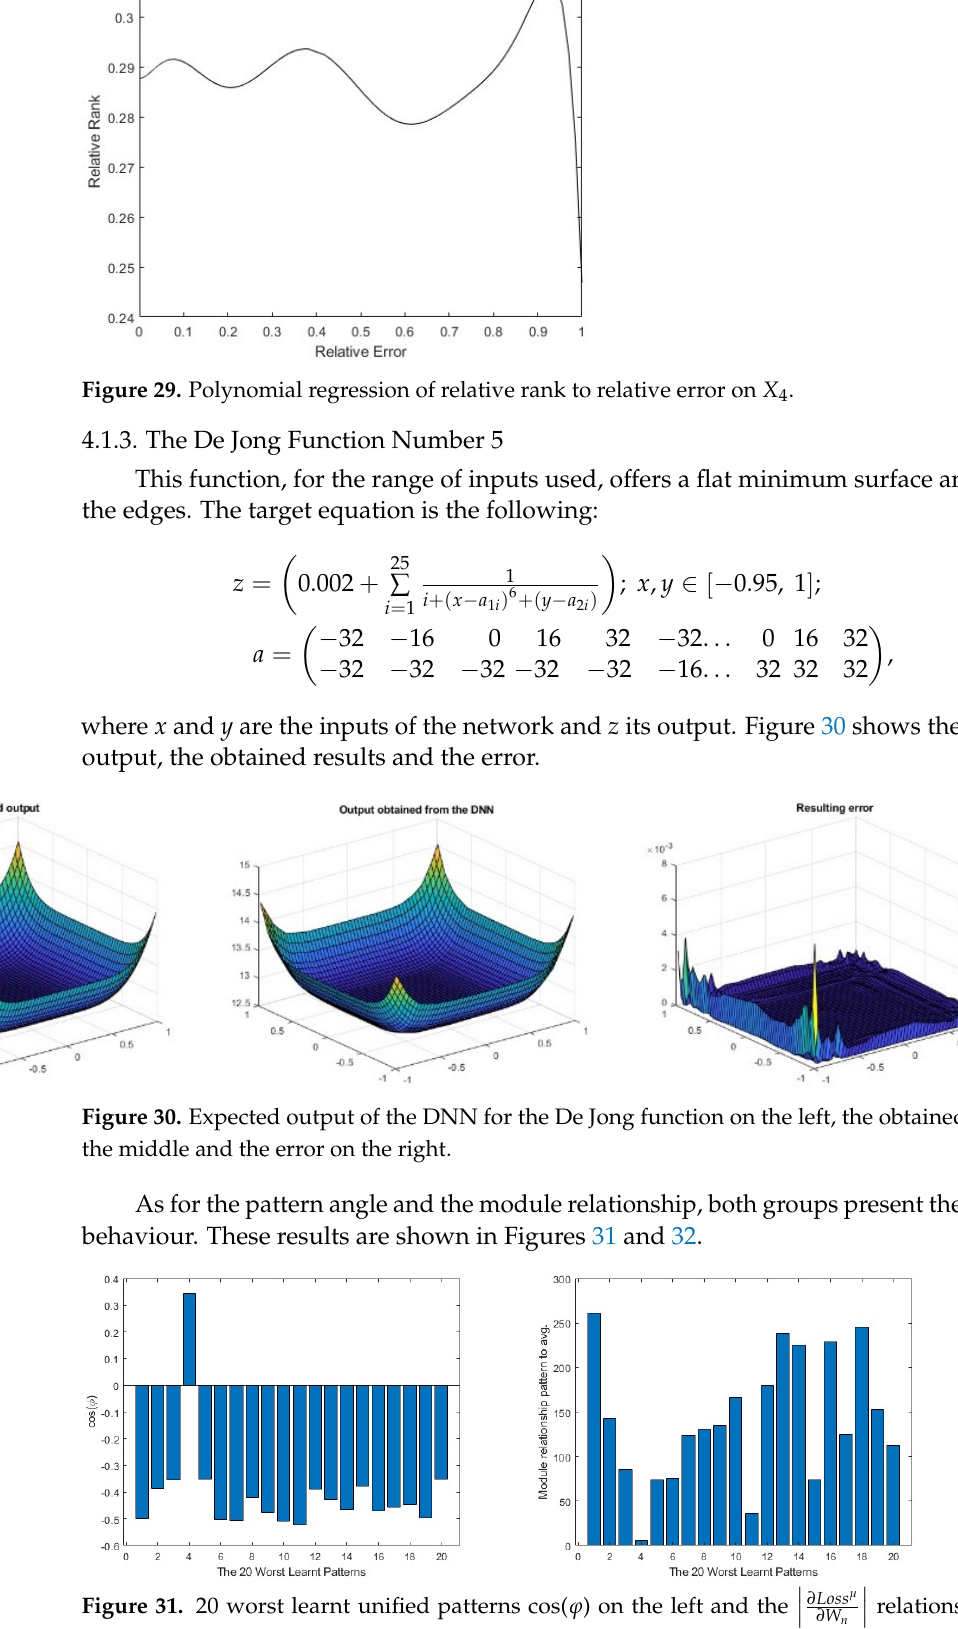
Figure 32. 20 best learnt unified patterns cos( φ ) on the left and the (cid:4698) (cid:3105)(cid:3013)(cid:3042)(cid:3046)(cid:3046) (cid:3339) (cid:3105)(cid:3024) (cid:3289) (cid:4698) relationship to the aver- age (cid:4698) (cid:3105)(cid:3013)(cid:3042)(cid:3046)(cid:3046) (cid:3105)(cid:3024) (cid:3289) (cid:4698) on the right. In the case of rank/error relationship of the ReLu layers, the situation is similar to the previous example, as the X 2 layer has a positive trend according to the error, revealing once again that there is a pattern with a high error completely misaligned with the average of all the patterns in that layer. In the case of X 4 , the behaviour is equivalent to the original example. This can be seen in Figures 33 and 34.